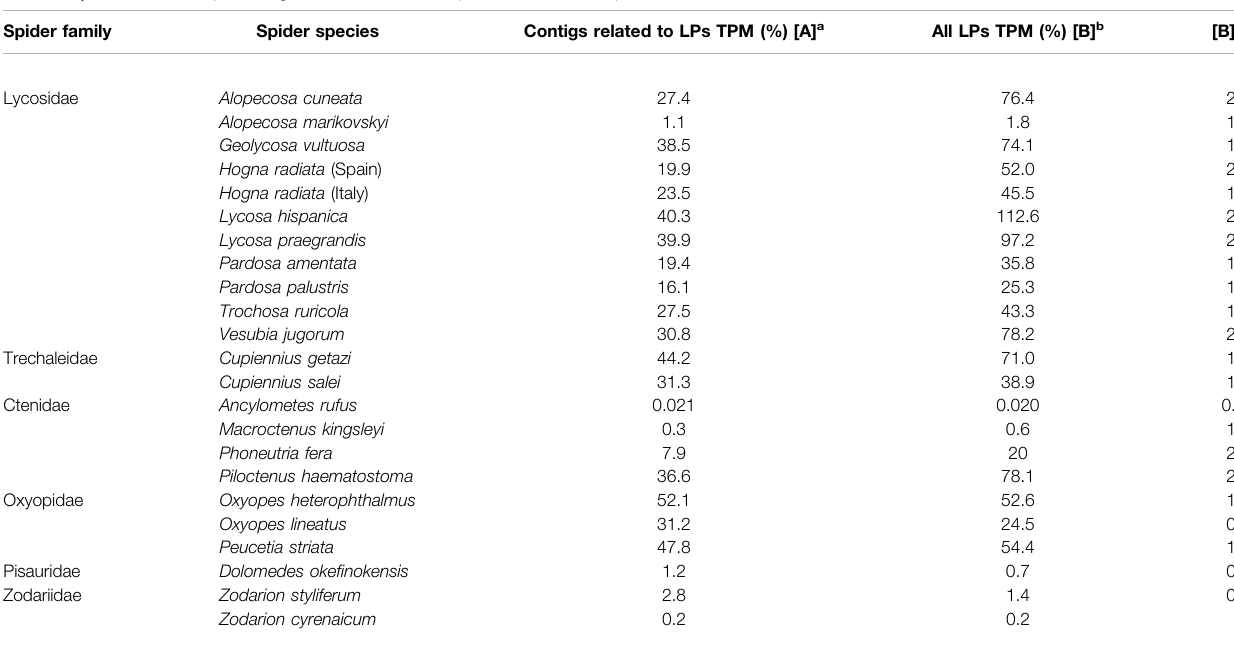
a TPM values are calculated for all individual contigs encoding different LPs structures and expressed as percentage of TPM corresponding to each transcriptome. b The amount(TPM %) ofall identi fi ed LPsina transcriptomeis given assum of the correspondingTPM valuesof the correspondingcontigs, which allowsa conclusionaboutthe relative abundance of each LP. Only complete peptides, with C-terminal amidation if present, were used for the calculation.